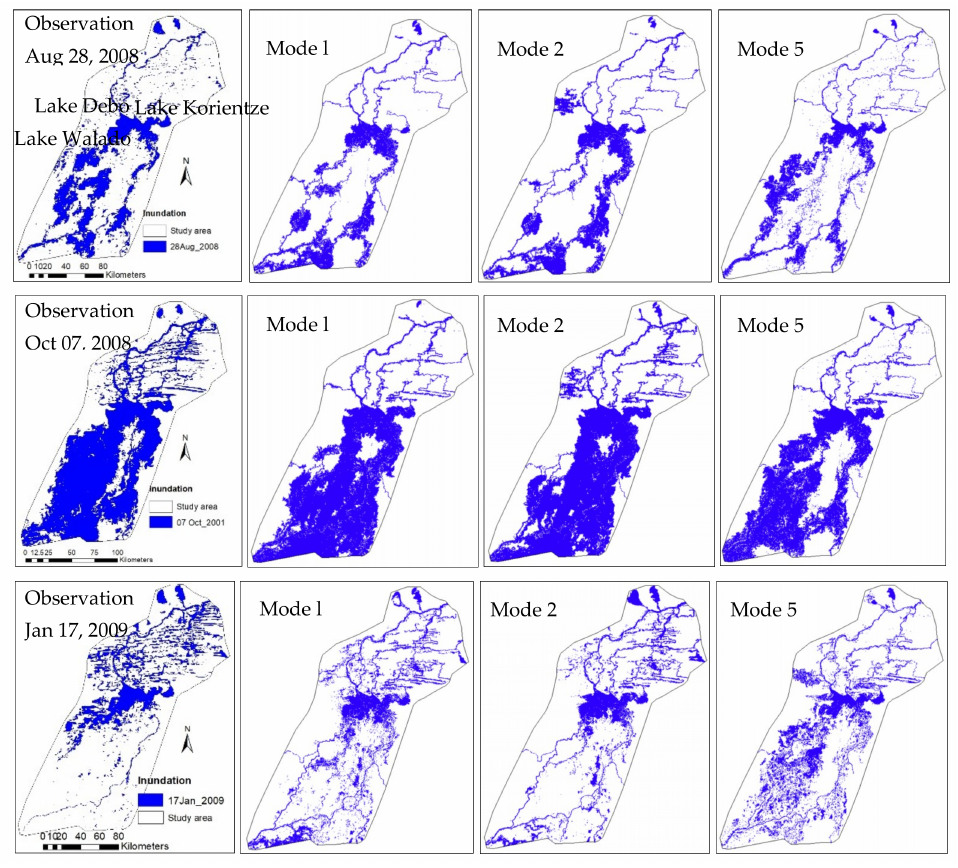
Figure 12. Inundation extent on 28 August 2008 ( left panel), 7 October 2008 ( middle ), and 17 January 2009 ( right